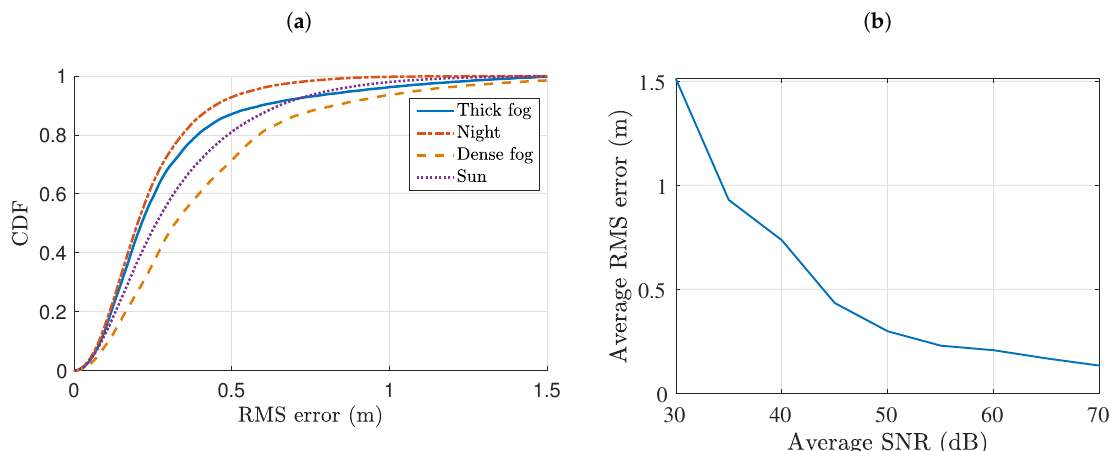
Figure 7. RMS error across the road: ( a ) during the day and ( b ) during the night.